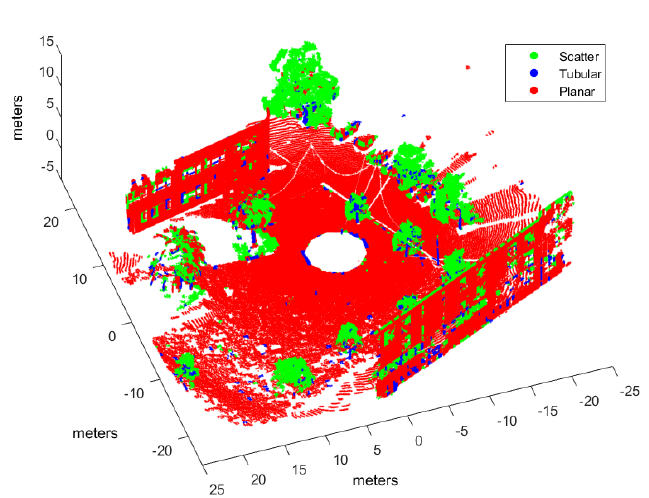
Figure 6. Urban point cloud classified by NN with F 2 .